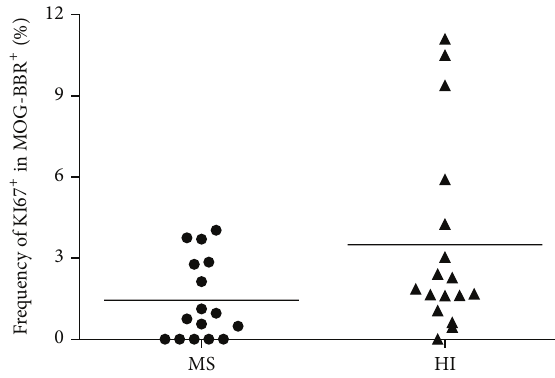
Figure 4: KI-67 expression in MOG-specific B cells: KI-67 marker was used to determine the proliferating states of MOG-BBR. The frequency of MOG-BBR positive for KI67 in MS ( 𝑛 = 16 ) was not different to HI ( 𝑛 = 17 ), (ns, 𝑃 = 0.06 ) Mann-Whitney test